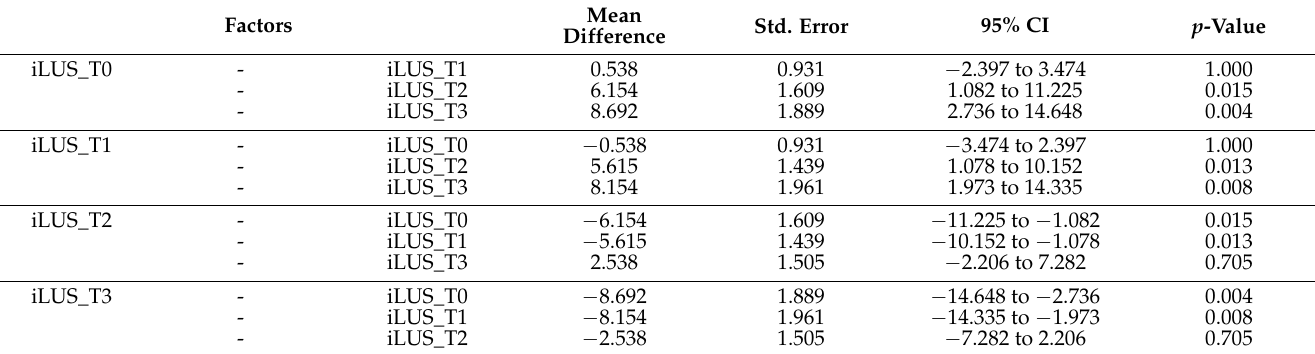
Table 3. Pairwise comparisons between ipsilateral CDH-LUS (iLUS) scores at different time points with a Bonferroni post hoc test.